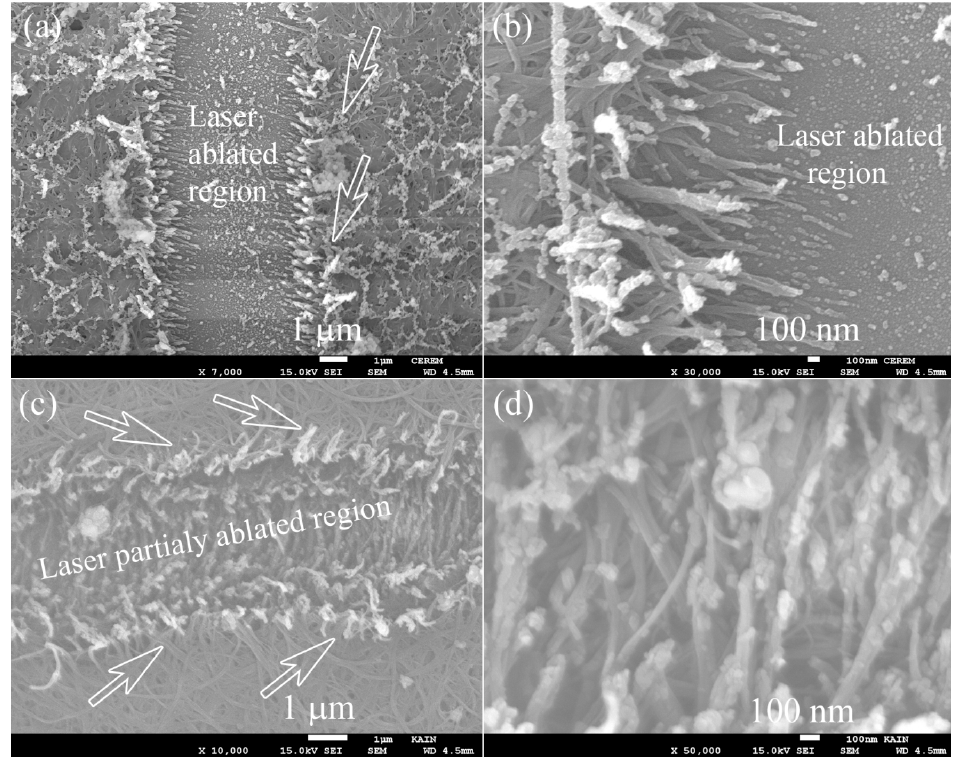
Figure 3. SEM images of SWCNT samples after IR laser irradiation with fluence reduction effects. ( a ) 169.77 J /cm 2 and ( c ) 21.22 J /cm 2 with 15 mm lens; ( a , c ) macroscopic view of area of SWCNTs ( a ) 169.77 J / cm 2 and ( c ) 21.22 J / cm 2 with 15 mm lens; ( a , c ) macroscopic view of area of SWCNTs irradiation, and ( b , d ) microscopic view of side regions showing connectivity. irradiation, and ( b , d ) microscopic view of side regions showing